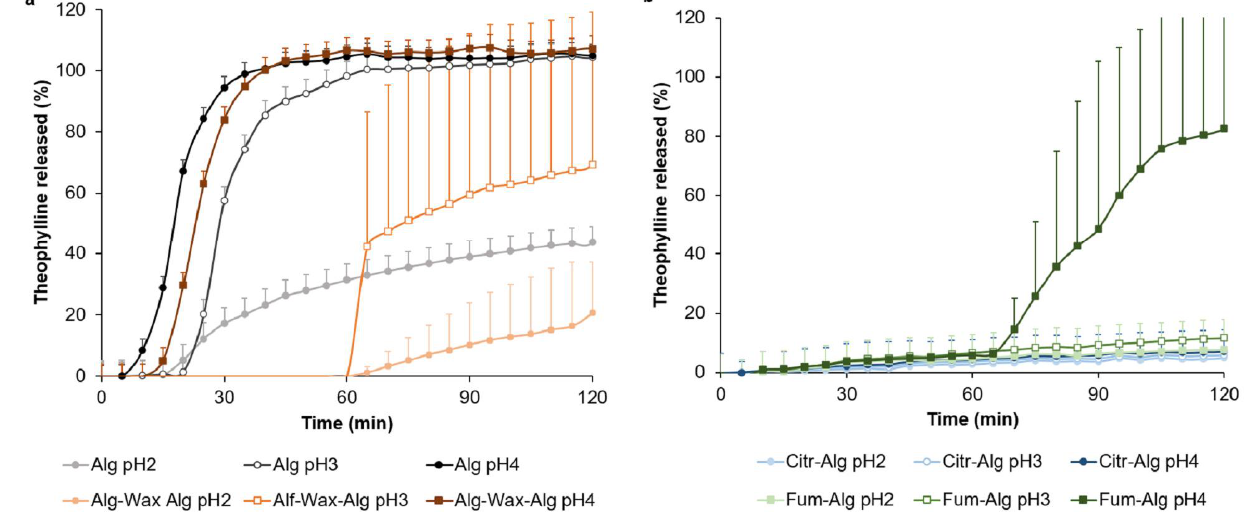
Figure 6. In vitro theophylline release from tablets coated with ( a ) single-layer Alg (F2) and triple- layer Alg-Wax-Alg (F5); ( b ) Fum-Alg (F6) and Citr-Alg (F7) in elevated gastric pH 2, 3, and 4.